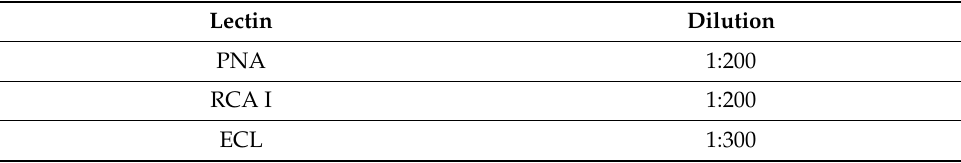
Table 3. Lectins used in lectin blotting and dilutions